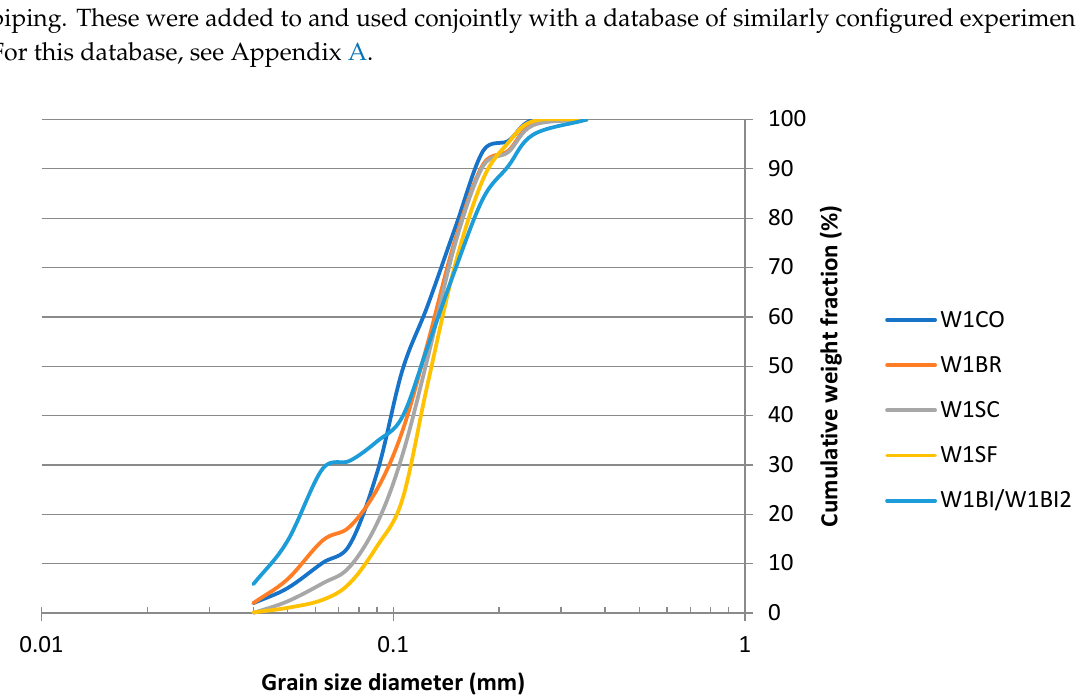
Figure 2. Cumulative grain size distributions for the investigated samples. Table 1. Properties of the various investigated porous media. Here D50 and D70 are weight-based fractions, Uc is the uniformity coefficient (D10/D60). The contribution of fines (particles with a grain diameter smaller than 63 µm) is expressed by fraction of the total mass and n is the porosity.